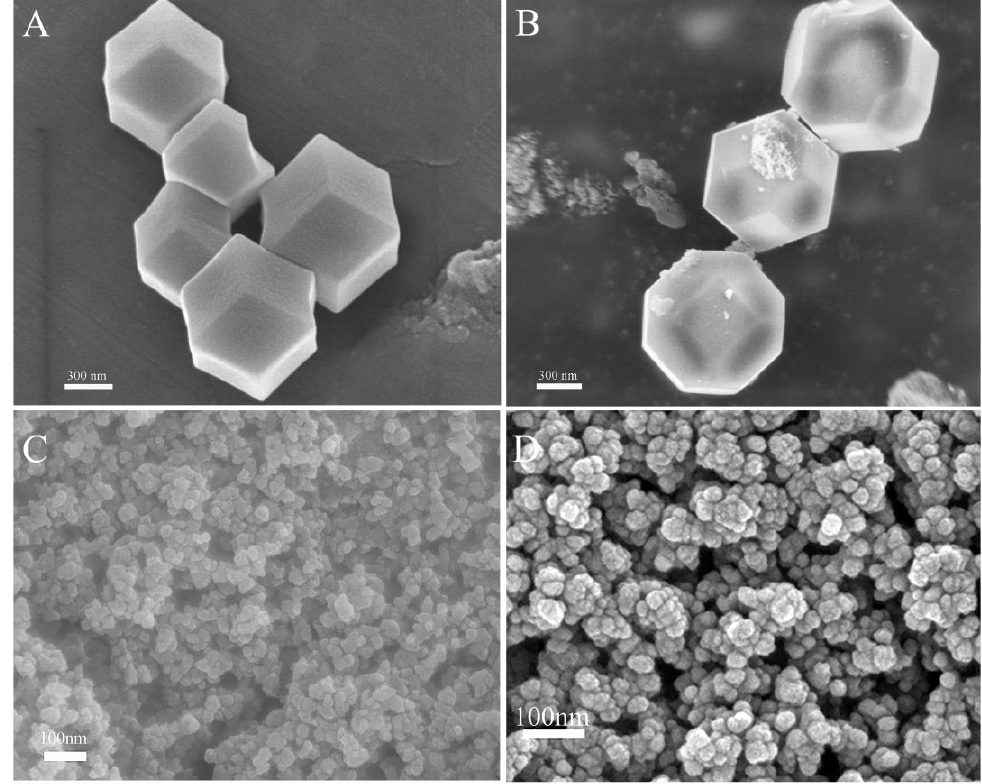
Figure 1. SEM images of Zn/Fe-ZIF ( A ), Zn/Fe-ZIF-NPC ( B ), NiHCF-NPs ( C ) and AuNPs ( D ).